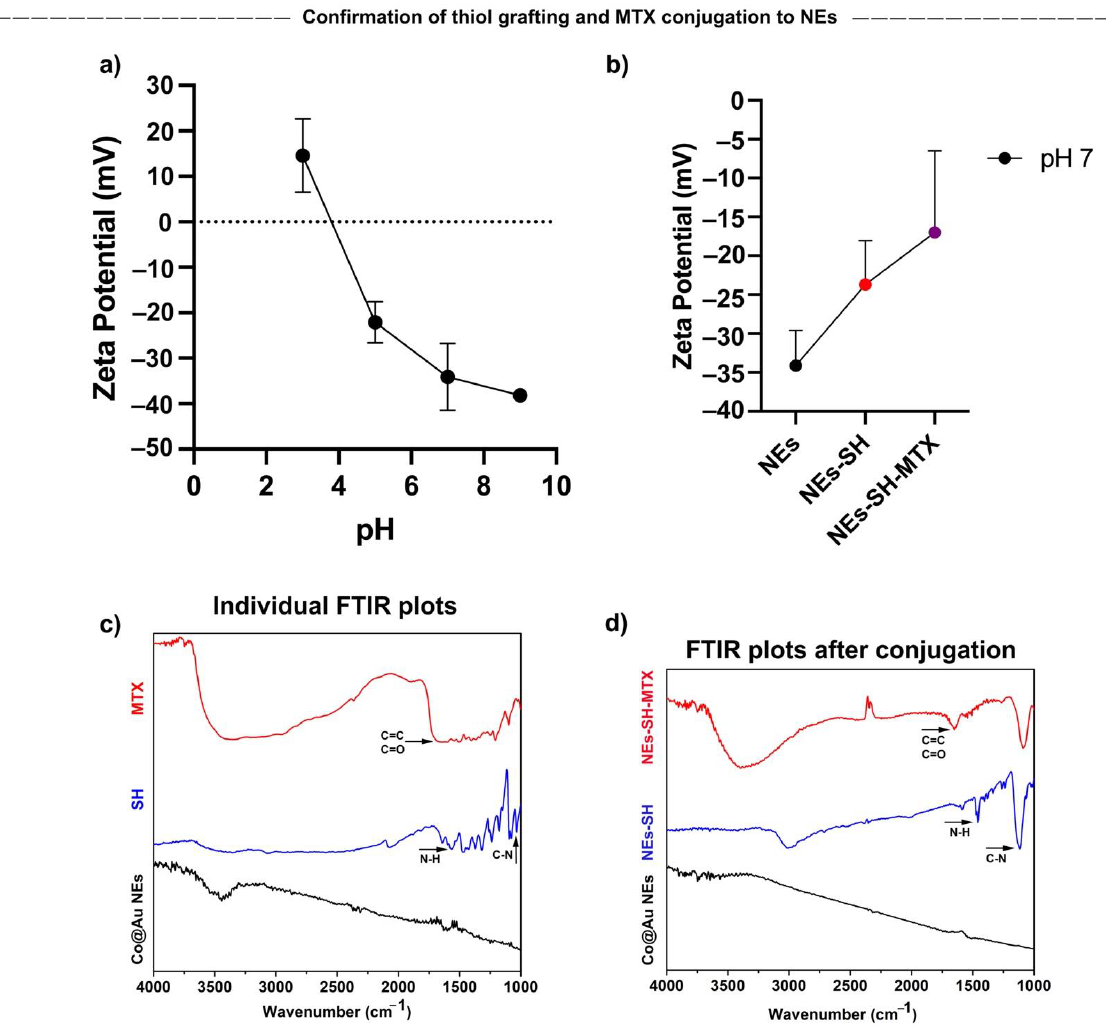
Figure 6. Characterization of elliptical Co@Au (Co@Au NEs) nanoparticles after thiol and MTX (SH-MTX) conjugation via Zetasizer and FTIR. ( a ) Dispersion ability of Co@Au NEs as analyzed by measuring zeta potential at varying pH. ( b ) Measurement of zeta potential after conjugation of Co@Au NEs with thiol (SH) and Methotrexate (MTX). ( c ) FTIR analysis of Co@Au NEs, thiol and MTX. ( d ) FTIR analysis of Co@Au NEs followed by thiol and MTX conjugation, confirming the successful grafting of MTX onto elliptical nanoparticles.